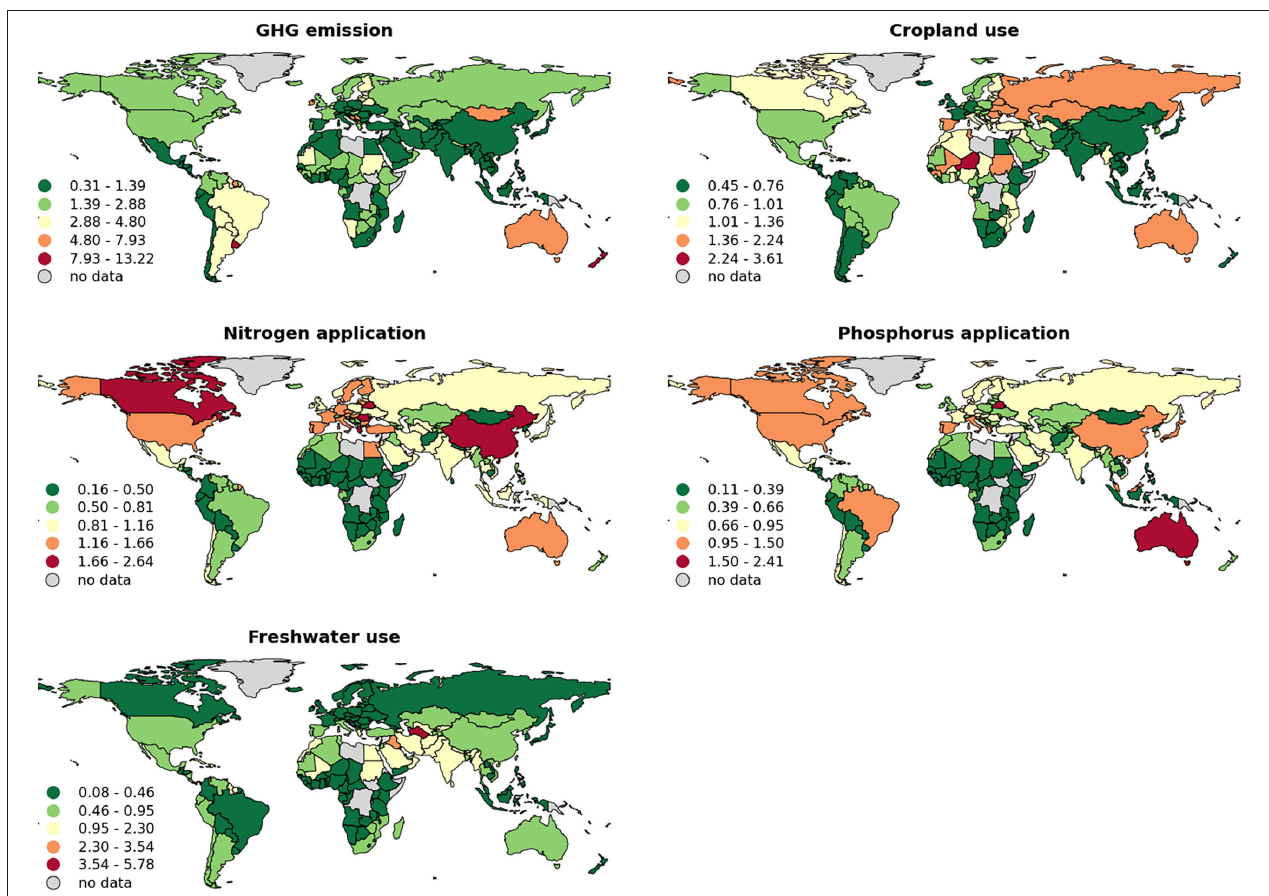
FIGURE 3 | Ratio of the per capita environmental footprints associated with current diets to food-related planetary boundaries. Environmental footprints regarding greenhouse-gas (GHG) emissions, cropland use, freshwater demand, nitrogen, and phosphorus application of national food consumption in year 2010 were estimated by Springmann et al. (2020). Per capita food-related planetary boundaries of global average were based on the estimates of Chaudhary and Krishna (2019) and Springmann et al.